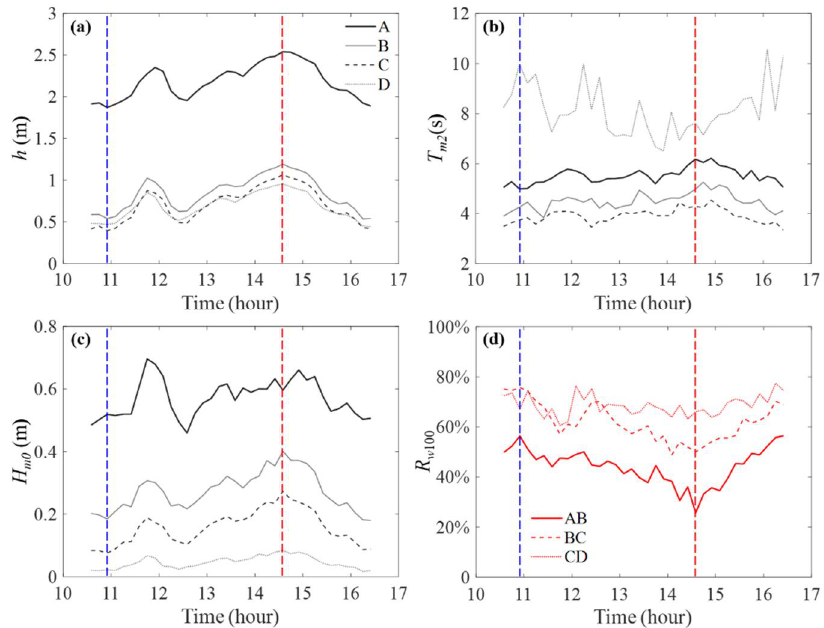
Figure 4. The water depth h ( a ), mean wave period T m 2 ( b ), and significant wave height H m 0 ( c ) measured at stations A to D from 10:30 to 16:30, September 16. ( d ) shows the wave attenuation rate over 100 m R w 100 (Equation (5)). The vertical red and blue lines indicate the time of the maximum and minimum water depth at station A over this time period.